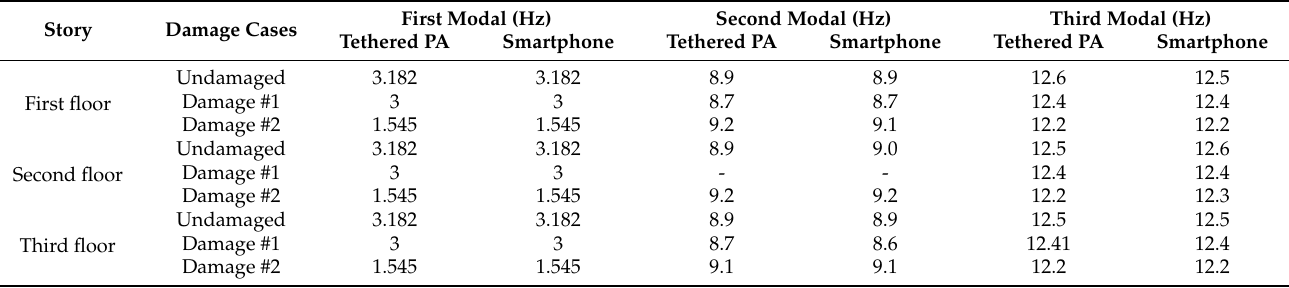
Table 1. Modal frequency results obtained using the tethered PA and smartphones.